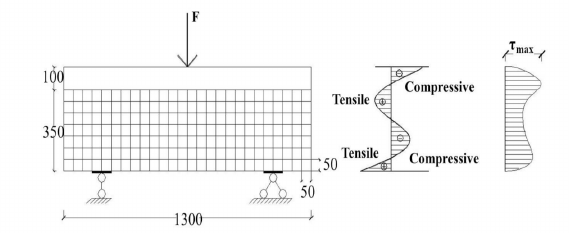
Figure 10. Normal strain and shear stress in cross-section.